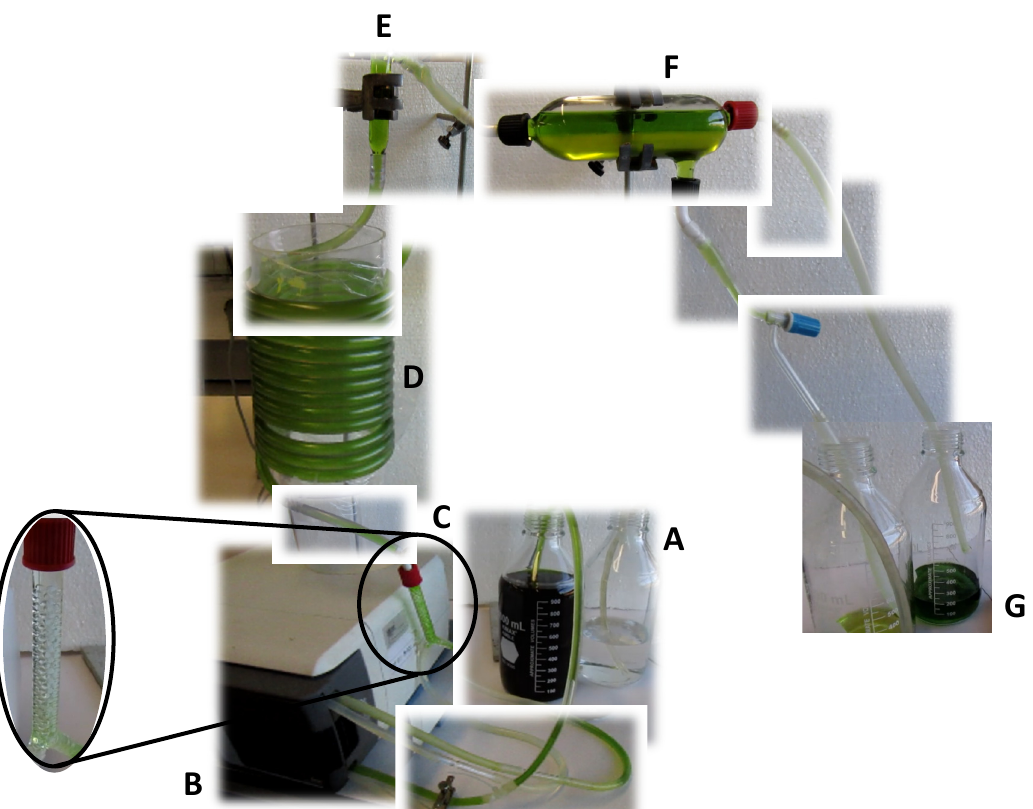
Figure 4. Continuous tubular separator. ( A ) Pre-equilibrated phases and sample solution; ( B ) peri- staltic pump; ( C ) phase mixer and turbulence generator; ( D ) continuous tubular separator; ( E ) pre- phase collector to help avoid turbulence in the phase collector; ( F ) phase collector with the interface harvesting port; and ( G ) collector flasks.